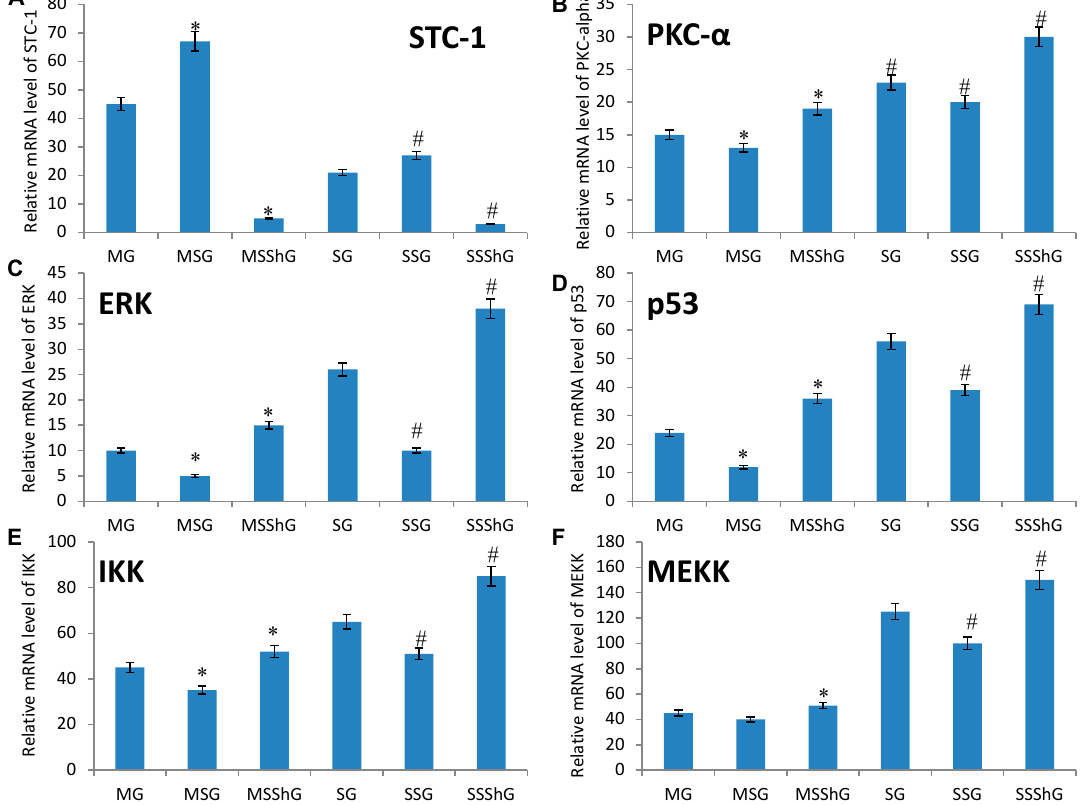
Figure 4. The effects of STC-1 on the mRNA levels of ROS-mediated molecules. Among 16 mice, eight mice were used to create RIRI models as a model group and eight mice were used as a sham group. Renal progenitor cells were isolated from the kidney cortex of RIRI model and sham mice after 16-h surgery. For the kidney cells isolated from eight model mice, they were further subdivided into three groups based on different treatment options (model group (MG); STC-1 expression group (MSG), the mice were transfected with STC-1 gene to overexpress STC-1; and STC-1 shRNA group (MSShG), the mice were transfected with STC-1 shRNA to knockdown STC-1). In the same way, the kidney cells from 8 sham mice were subdivided into another three groups based on different treatment options (sham group (SG); STC-1 expression group (SSG), the mice were transfected with STC-1 gene to overexpress STC-1; and STC-1 shRNA group (SSShG), the mice were transfected with STC-1 shRNA to knockdown STC-1). The mRNA levels were measured from the same part of renal tissues obtained after 4-h surgery: ( A ) the changes of mRNA levels of STC-1 in different groups; ( B ) the changes of mRNA levels of PKC- α in different groups; ( C ) the changes of mRNA levels of ERK in different groups; ( D ) the changes of mRNA levels p53 in different groups; ( E ) the changes of mRNA levels of IKK in different groups; ( F ) the changes of mRNA levels of MEKK-1 in different groups; ( G ) the changes of mRNA levels of JNK in different groups; ( H ) the changes of mRNA levels of ASK-1 in different groups; ( I ) the changes of mRNA levels of caspase-3 in different groups; and ( J ) the changes of mRNA levels of NF- κ B in different groups. All data were normalized to actin, and presented as the mean values ˘ S.D. * p < 0.05 compared to the model group and # p < 0.05 compared to the sham